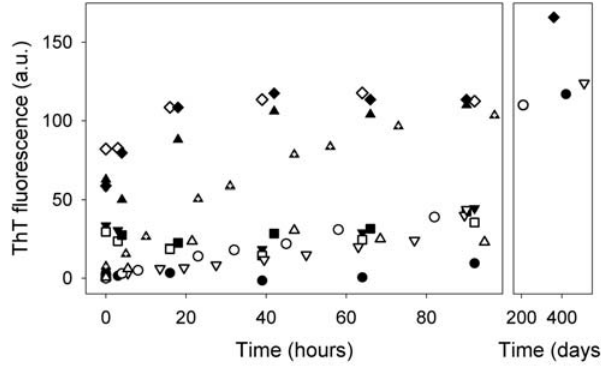
Figure 2. Formation of ThT-binding structures when apo SOD1 mutants and WT are incubated at 37 u C. Fluorescence due to ThT binding to SOD1 mutants (presented as arbitrary units, A.U.) for apo T54R SOD1 ( N ); apo L67V SOD1 ( D ), apo D90A SOD1 ( = ), apo I113F SOD1 ( % ), apo V87M SOD1 ( . ), apo WT SOD1 (O), apo L144F SOD1 ( & ), apo I35T SOD1 ( m ), apo V97M SOD1 ( m ), apo G93A SOD1 ( e ), apo I113T SOD1 ( ¤ ), during the incubation of the samples at 37 u C. Apo G93D SOD1 mutant is not reported because the oligomeric species formed precipitates after about 30 hours of incubation.